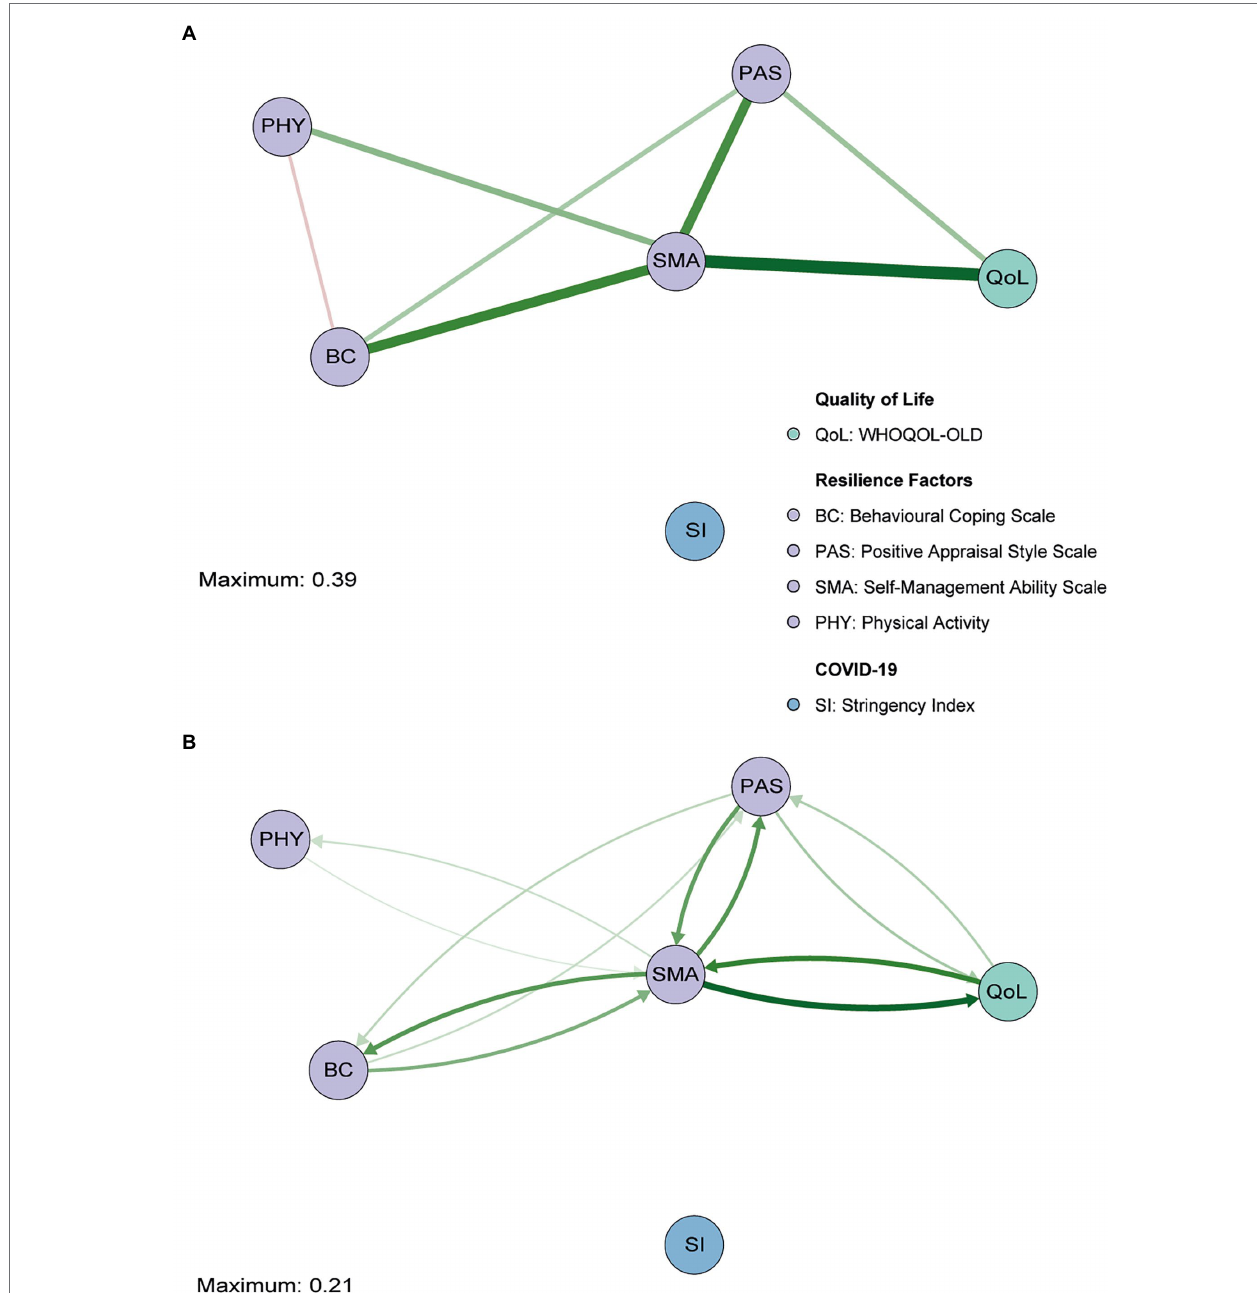
FIGURE 1 | Gaussian graphical model (GGM; A ) and directed relative importance network (B) of overall quality of life (QoL; green), the resilience factors (purple), and the stringency index (blue). The maximum value represents the highest edge weight included in the